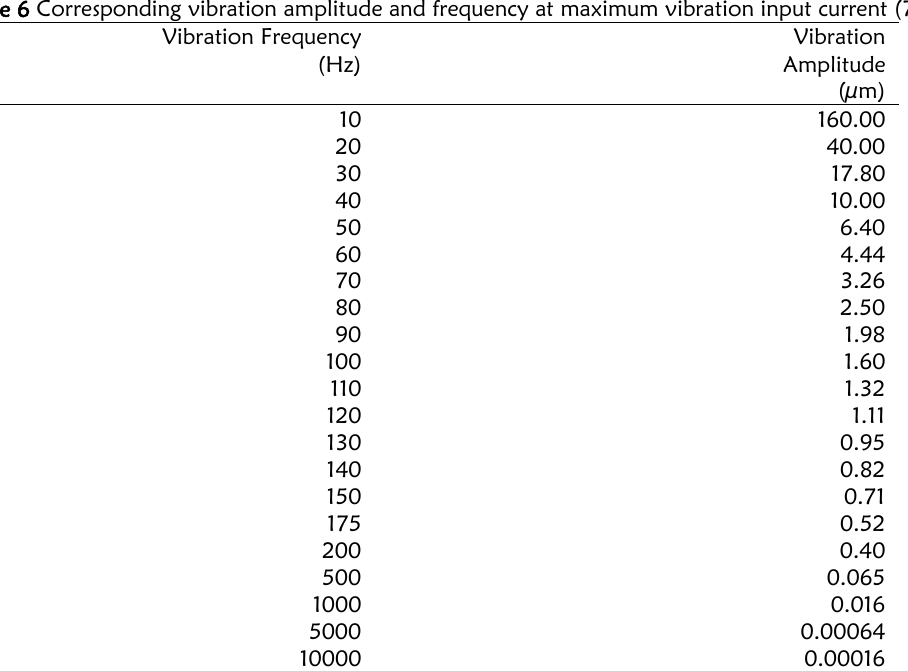
Table 6 Corresponding vibration amplitude and frequency at maximum vibration input current